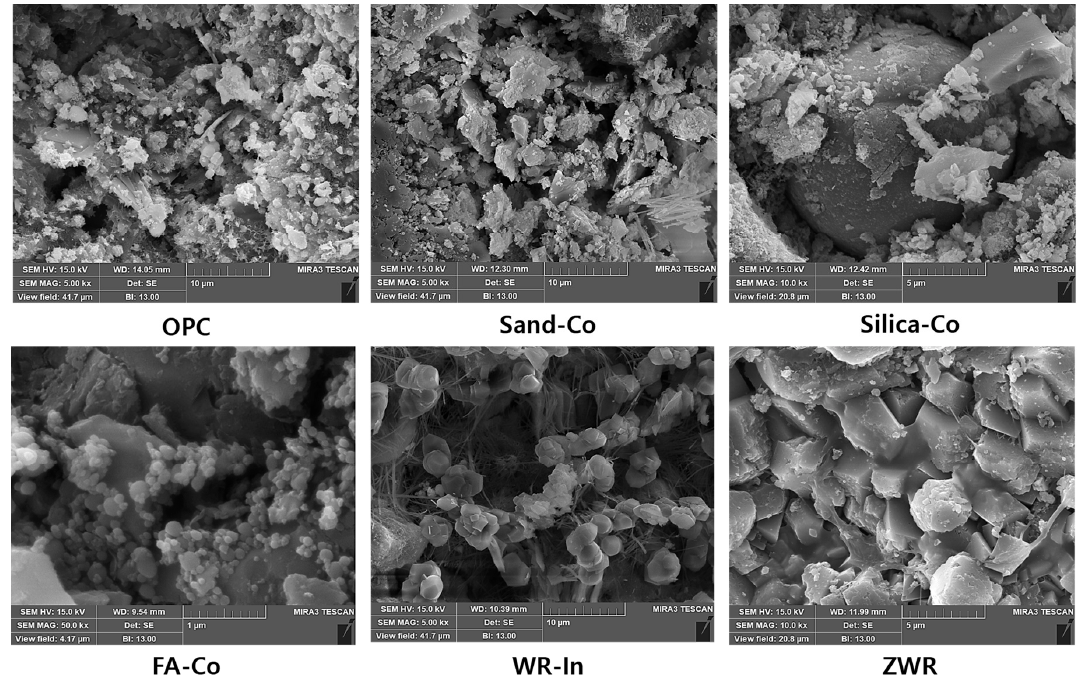
Figure 16. Curing at 28 days and the electron scanning microscope analysis.